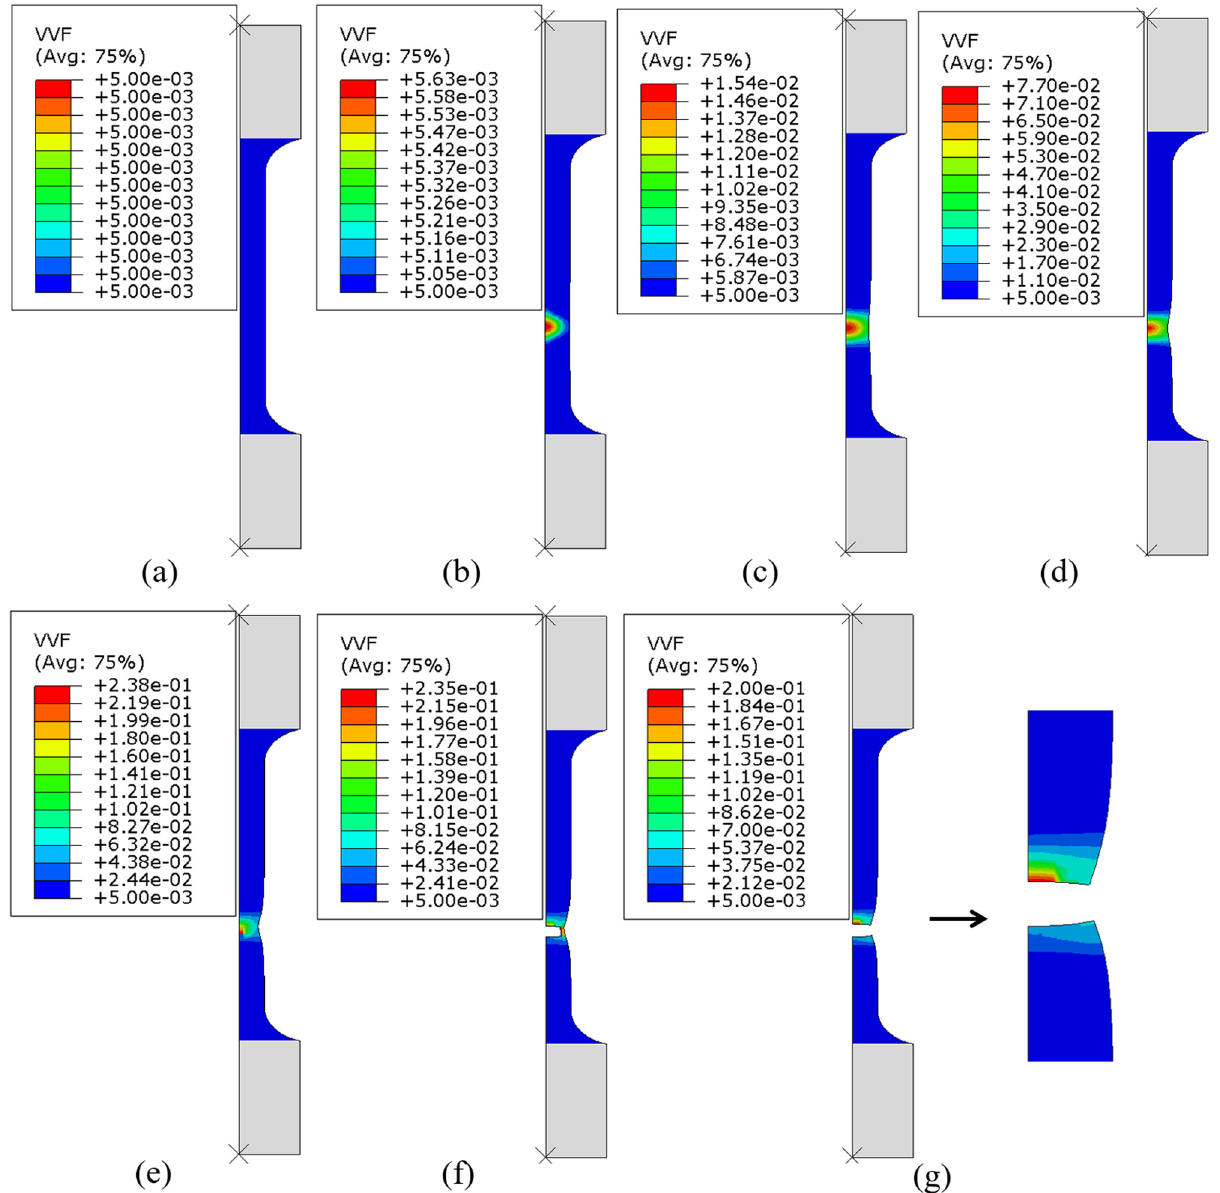
Figure 9: The distribution of void volume fraction at the true strain of ( a ) 0 s − 1 , ( b ) 0.05 s − 1 , ( c ) 0.1 s − 1 , ( d ) 0.15 s − 1 , ( e ) 0.2 s − 1 , ( f ) 0.229 s − 1 , and ( g ) 0.23 s − 1